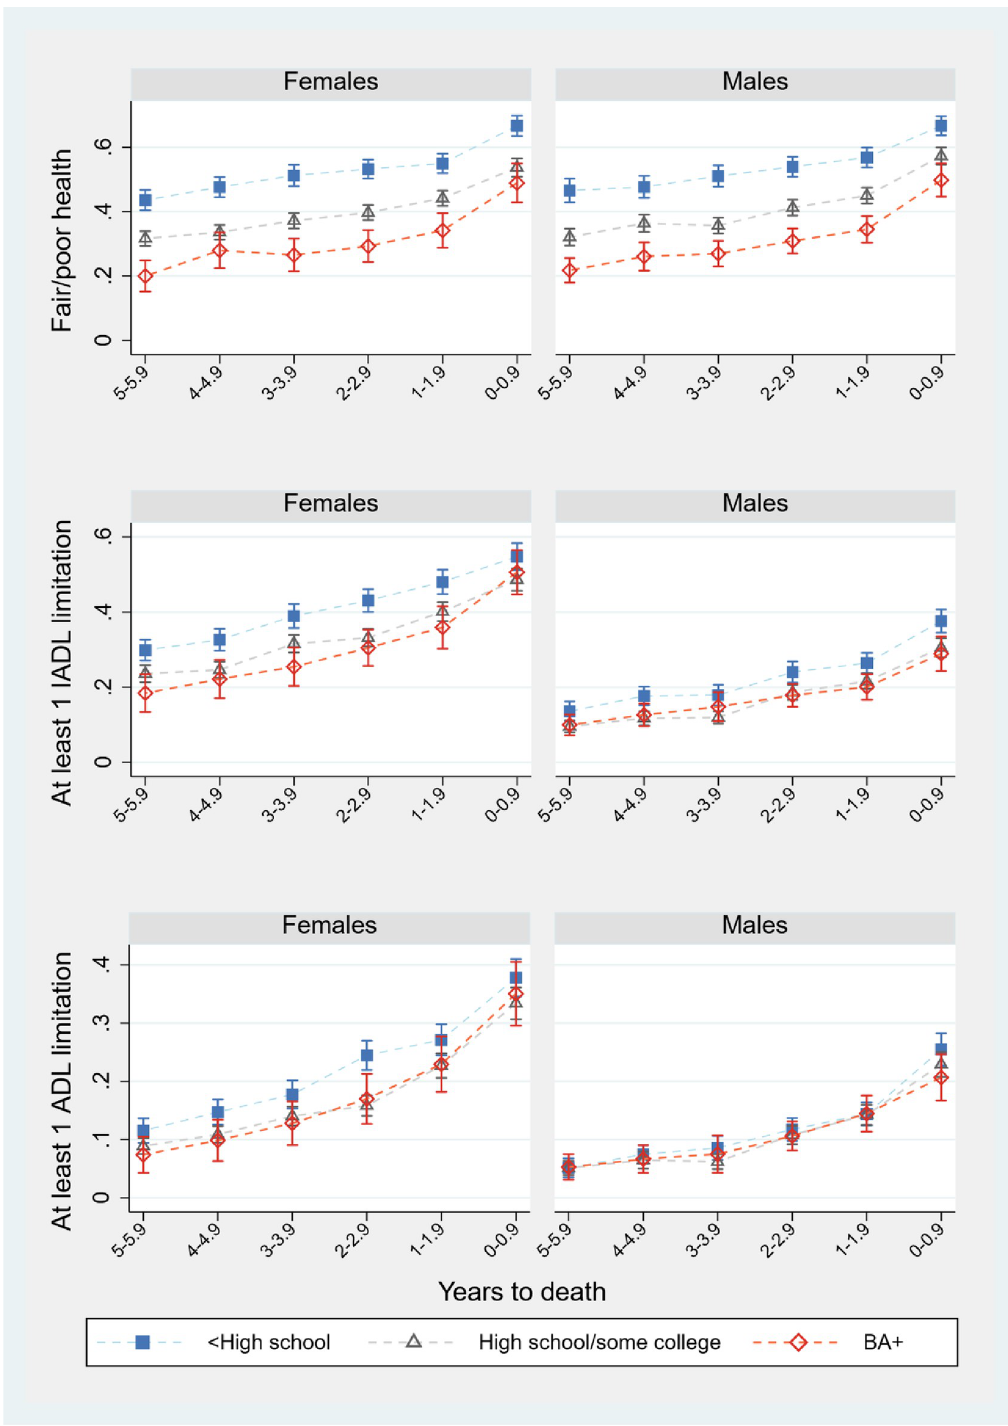
Fig 4. Proportion of population in given health state across final years of life, by educational attainment (with 95% confidence intervals).